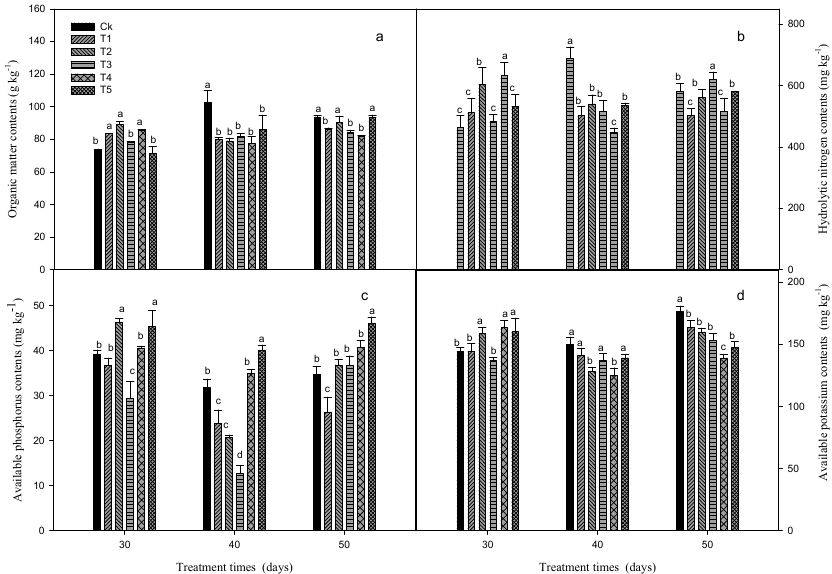
Figure 9. Soil chemical properties with different graphene treatments (mean ± 1 S.D., n = 3). Values followed by the same letter for the same days are not significantly different at p < 0.05. Ck, T1, T2, T3, T4, and T5 represent 0, 25, 50, 100, 250, and 500 mg L -1 graphene treatments, respectively. ( a ): organic matter contents; ( b ): hydrolytic nitrogen contents; ( c ): available phosphorus contents; and ( d ): available potassium contents.